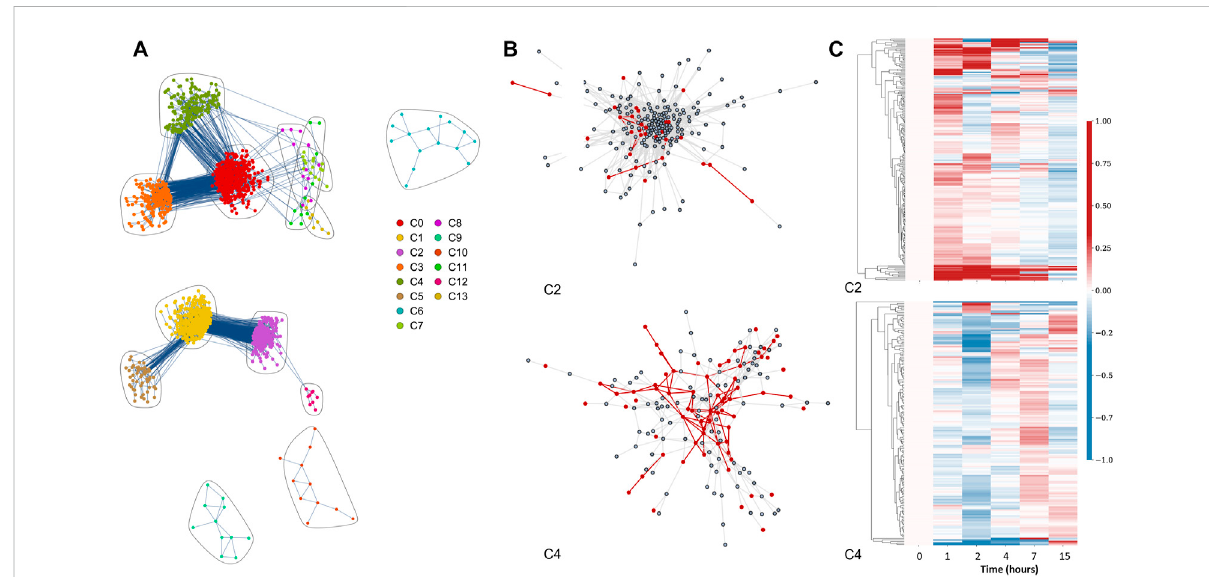
FIGURE 3 Differential network analysis for the B cell experiment. (A) Differential network with community structure found by the Louvain community detection method. (B) Isolated visualizations of C2 (top) and C4 (bottom) communities with red highlights indicating genes found in statistically signi fi cant Reactome pathways (FDR < 0.05), and their corresponding edges in the network. (C) Heatmaps of C2 (top) and C4 (bottom) over 15 h (6time points).Columnsrepresenttime pointswhile rowsdenote genes.Theserow datademonstratethedifference ineach entry ’ sexpression relative to time 0. The relative values were determined by subtracting the individual time points from time point 0 and then normalizing using a Euclidean norm, so that each row ranges from -1 (down-regulation) to 1 (up-regulation). For the dendrogram clustering we used the complete- linkage method (Farthest Point Algorithm) Defays (1977); Hartigan